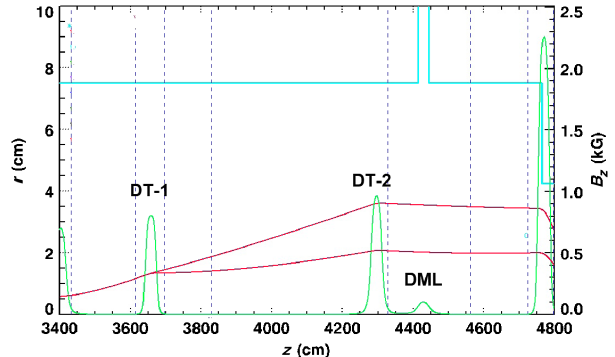
FIG. 11. Beam envelope radius predicted by the XTR code for the maximum DT-1 magnetic field (1.45 kG) and the minimum DT-1 field (0.80 kG) used for these experiments (red curves). Also shown are DST solenoid fields on axis (green curves) and the beam pipe wall (cyan lines). (DT-1 field for maximum beam size is shown). BPM locations are marked with blue dashed